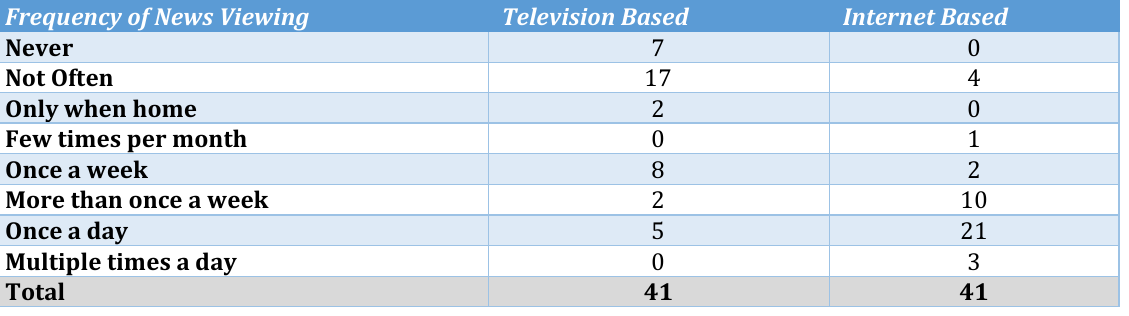
Table 4: Television and Internet News Viewing Frequency